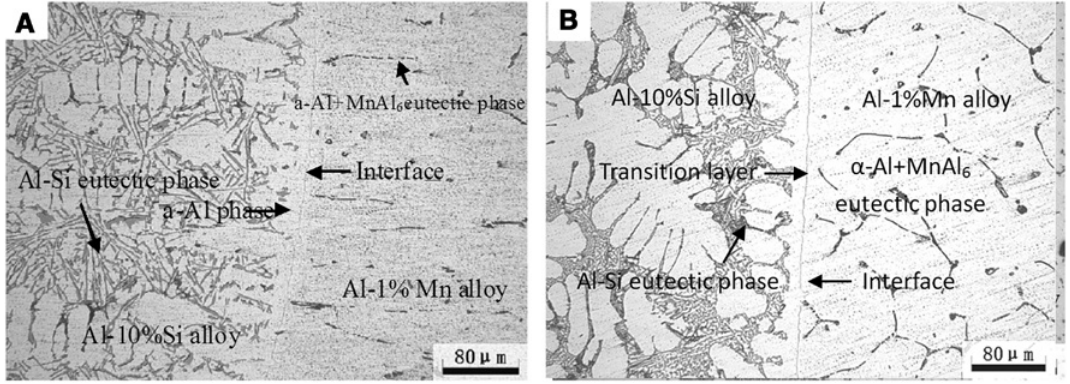
Figure 6: Microstructures of clad slab on cross-section with different casting speed: (A) 70 mm·min -1 and (B) 80 mm·min -1